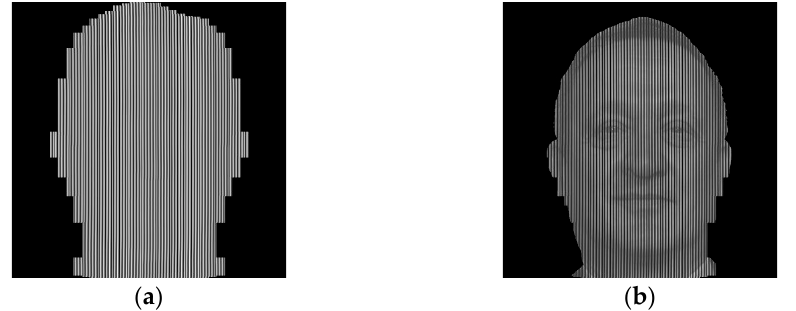
Figure 3. Hologram of focused images: ( a ) from the object—depth map; ( b ) from the full 3D object—depth map with superposed texture.